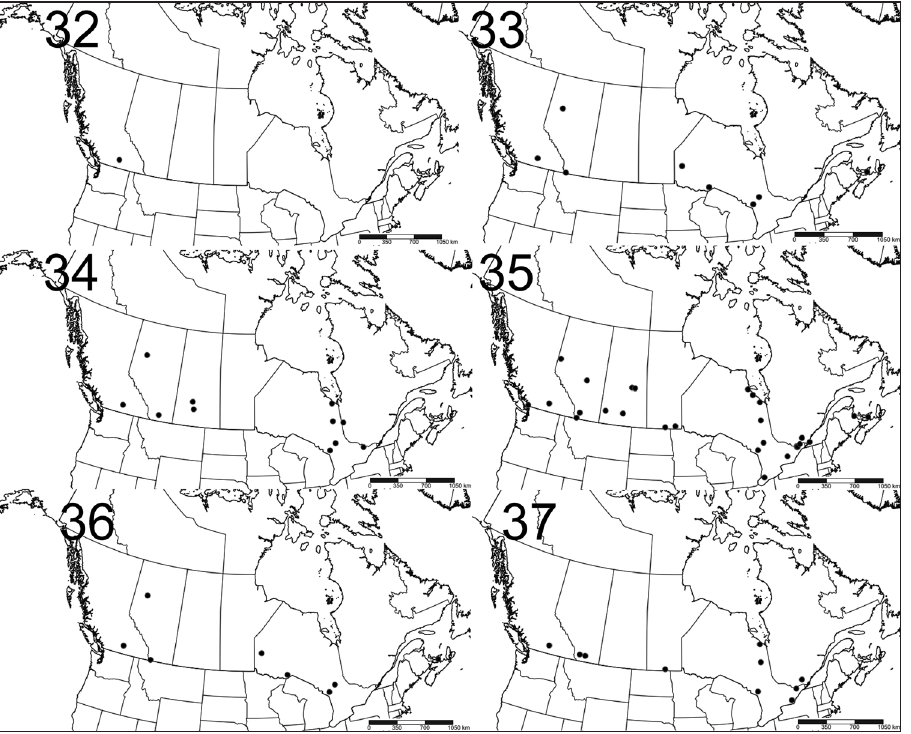
Figure 32–37. 32 Known localities of Eurytoma shorthousei in Canada 33 Known localities of E. iniquus in Canada 34 Known localities of E. longavena in Canada 35 Known localities of E. discordans in Canada. 36 . Known localities of E. imminuta in Canada 37 Known localities of E. spongiosa in Canada. Females. Body length 2.1–5.0 mm. Color: Black except for the following yellow – basal half of scape, pro- and mesofemur, basal pro- and mesotibia, apex of